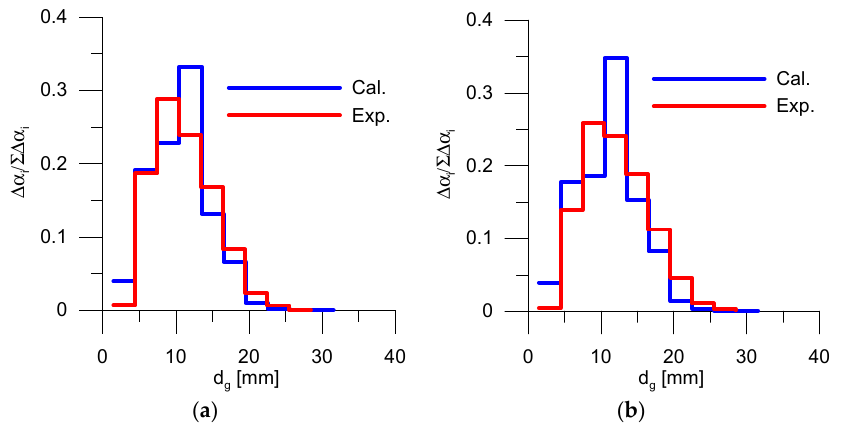
Figure 15. Evolution of normalized bubble size distribution at the WMS plane (Case 2): ( a ) t = 29 s; ( b ) t = 49 s.